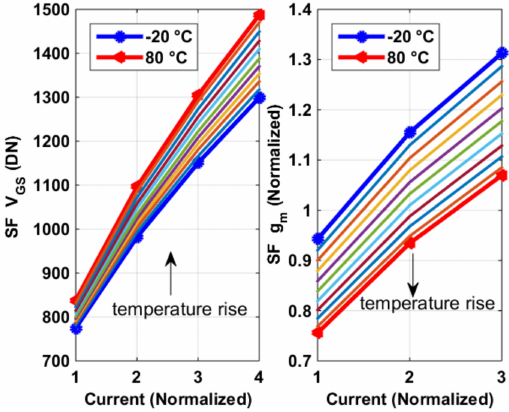
Figure 6. Measurement outputs of the process sensors ( left ) and their extracted g m,SF ’s temperature dependency ( right ), with constant current